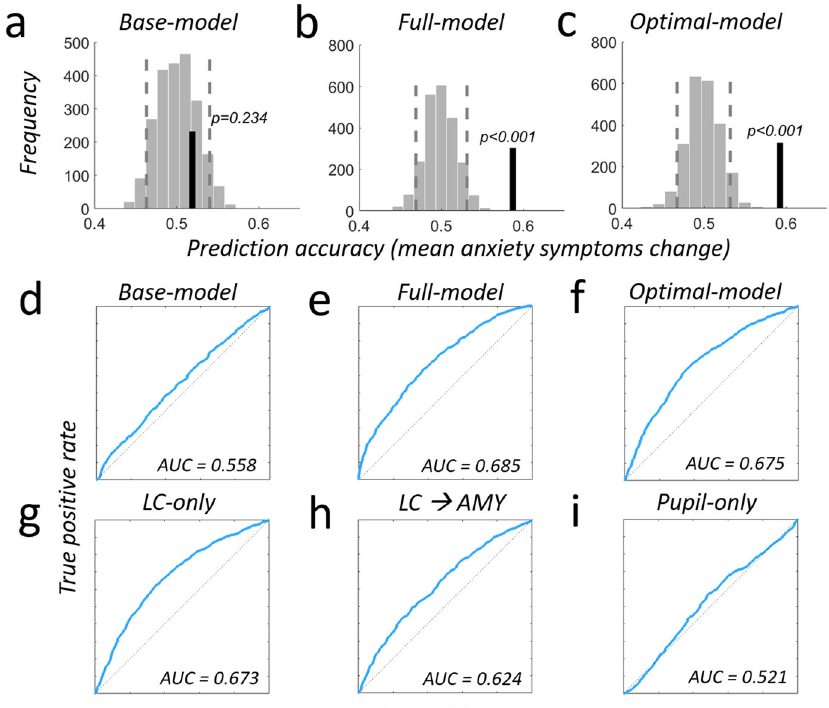
Fig. 8 Comprehensive model comparison for predicting anxiety symptom change. a – c Prediction analyses were based on a leave-two-subject-out cross- validation procedure and their signi fi cance was tested using a permutation test with 1000 permutations for each possible left-out pair combination. Light gray bars show the distribution of prediction accuracies that can be expected by chance (shuf fl ed labels, see methods sections for details). Dashed vertical lines represent the 5th and 95th percentile of this distribution. Vertical black line indicates the obtained out-of sample accuracy. a A base-model containing scores from anxiety and pretrauma surveys does not predict the individual mean changes in anxiety symptom severity due to real-world stress above chance (out-of-sample accuracy = 51.86%, p = 0.234, R 2 = 0.08, adjusted R 2 = 0.037). b Using a full model that additionally contains behavioral-, neural- and pupil data predicts mean anxiety increases signi fi cantly above chance (out-of-sample accuracy = 58.7%, p < 0.001, R 2 = 0.57, adjusted R 2 = 0.50). Compared to the base-model, the full model increases the explained variance by 49% and the adjusted explained variance by 47%. Locus coeruleus contribution is signi fi cant ( p = 0.038). c The optimal model, established using a stepwise-regression procedure (Methods), shows similar prediction improvements (out-of-sample accuracy = 59.2%, p < 0.001, R 2 = 0.56, adjusted R 2 = 0.52) but comprises only four parameters: locus coeruleus upregulation response ( p = 0.025), behavioral congruency-sequence effect (CSE, p = 0.031), pupil ( p = 0.05) and LC-NE-Amygdala coupling during the upregulation response ( p < 0.001). Compared to the base-model, this sparse model predicts 49% more of the variance and also 48% more of the adjusted variance. d – i Receiver operating characteristic (ROC) plots and area under the curve (AUC) for different combinations of measures predicting anxiety: ( d ) Base-model, ( e ) Full-model, ( f ) Optimal model, ( g ) LC-only, ( h ) LC-Amygdala only, ( i ) pupil only. Please see Supplemental Table S7 for